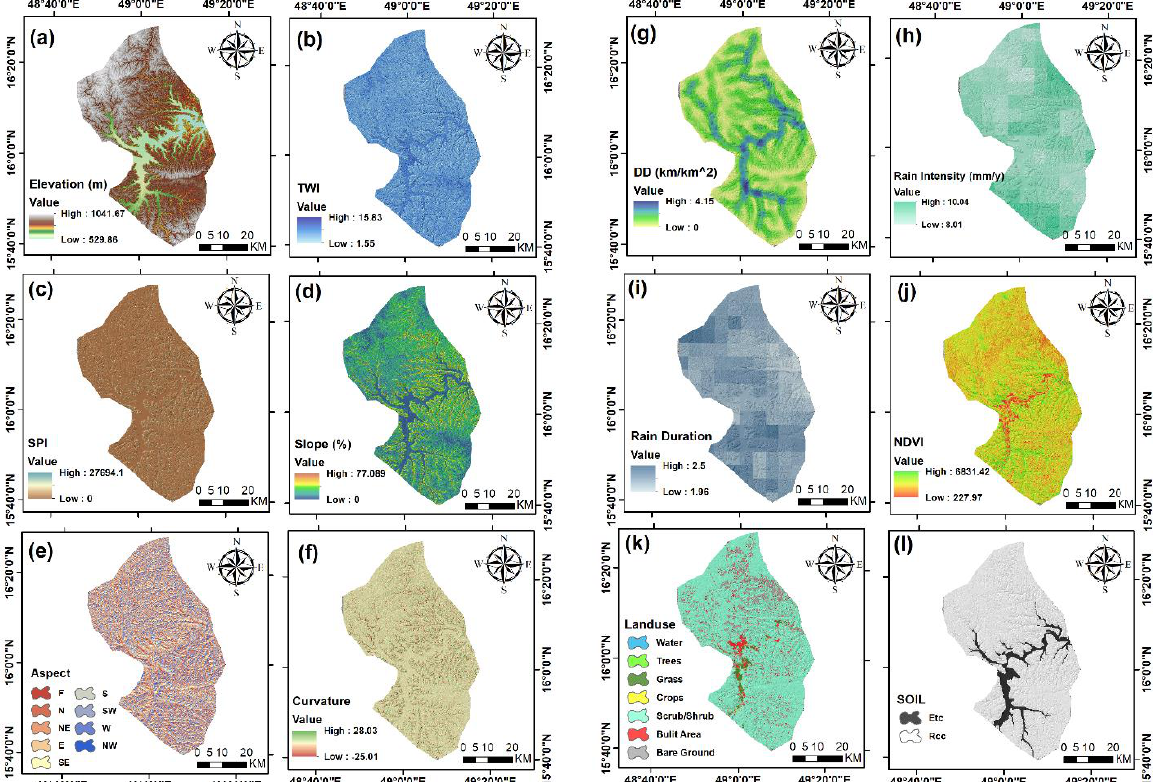
Figure 5. Maps of conditioning factors for flash flood: ( a ) elevation, ( b ) topographic wetness index (TWI), ( c ) stream power index (SPI), ( d ) slope, ( e ) aspect, ( f ) curvature, ( g ) drainage density (Dd), ( h ) rain intensity, ( i ) rain duration, ( j ) normalized difference vegetation index (NDVI), ( k ) land use, and ( l ) soil.